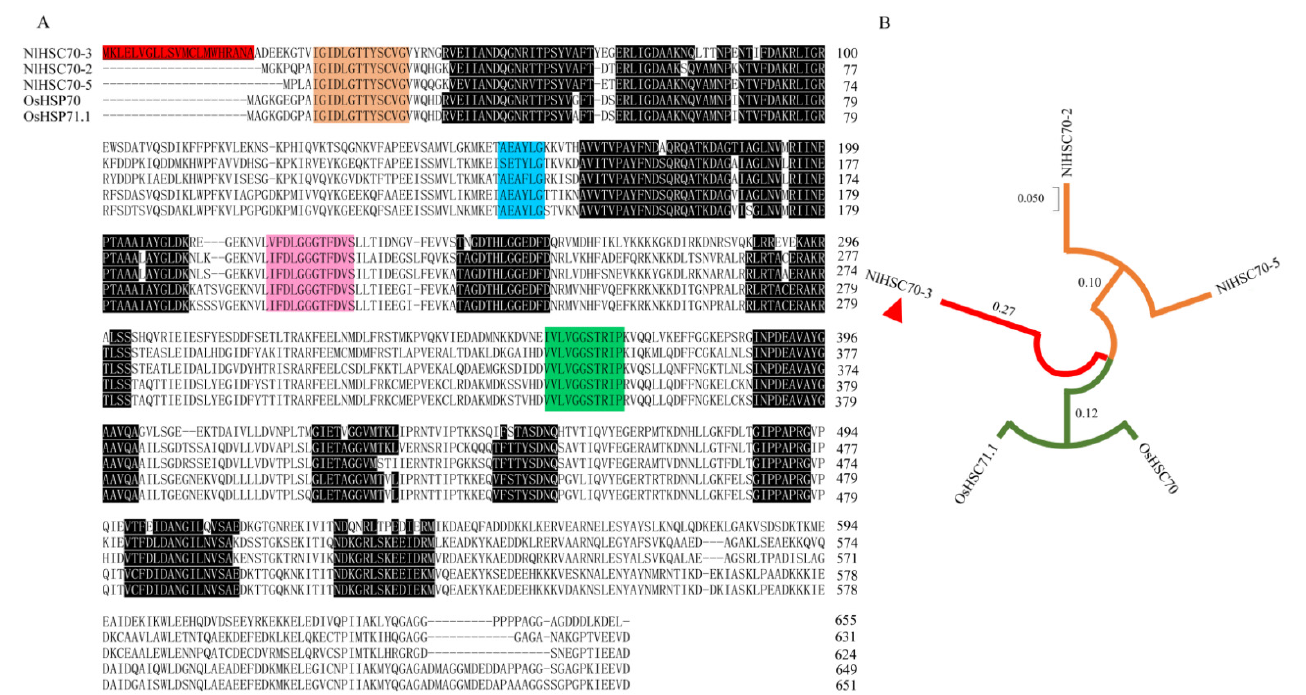
Figure 6. Sequence comparison of NlHSC70-3 with other HSP70s of rice and BPH. ( A ) Alignment of amino acid sequences of NlHSC70-3 with OsHSP70 and OsHSP71.1 of rice, and NlHSC70 and NlHSC70 of BPH. GIDLGTTYSCVG domain, AEAYLGK domain, IFDLGGGTFDVS domain, and VLVGGSTRIPK domain are indicated by orange, blue, pink and green. Similar amino acid sequences of NlHSC70-3, NlHSP70s, OsHSP70 and OsHSP71.1 are indicated by black shading. ( B ) Phylogenetic analysis of heat shock protein 70 from N. lugens and rice on amino acid sequences by the neighbor-joining method (1000 replicates). NlHSC70-3 is shown with a red triangle.